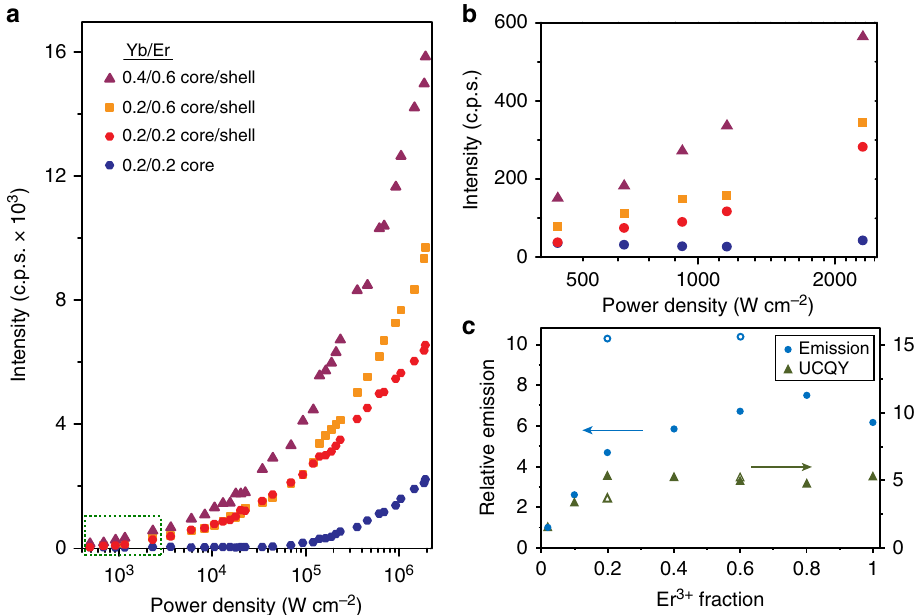
Fig. 3 UCNP emission as a function of laser intensity. a Single 8-nm UCNP emission (496 – 745 nm) as a function of 980 nm laser excitation density. b Emission at low intensities from highlighted area (green dash) in a . c Emission (circles) and QYs (triangles) of single core/shell UCNPs (solid symbols) and aUCNPs (open symbols) relative to 20% Yb 3 + 2% Er 3 + core/shell UCNPs 13 . Values are based on averages of between 50 and 300 single UCNPs excited at a power density of 2 × 10 6 W cm − 2 . Relative QYs are calculated as in Methods